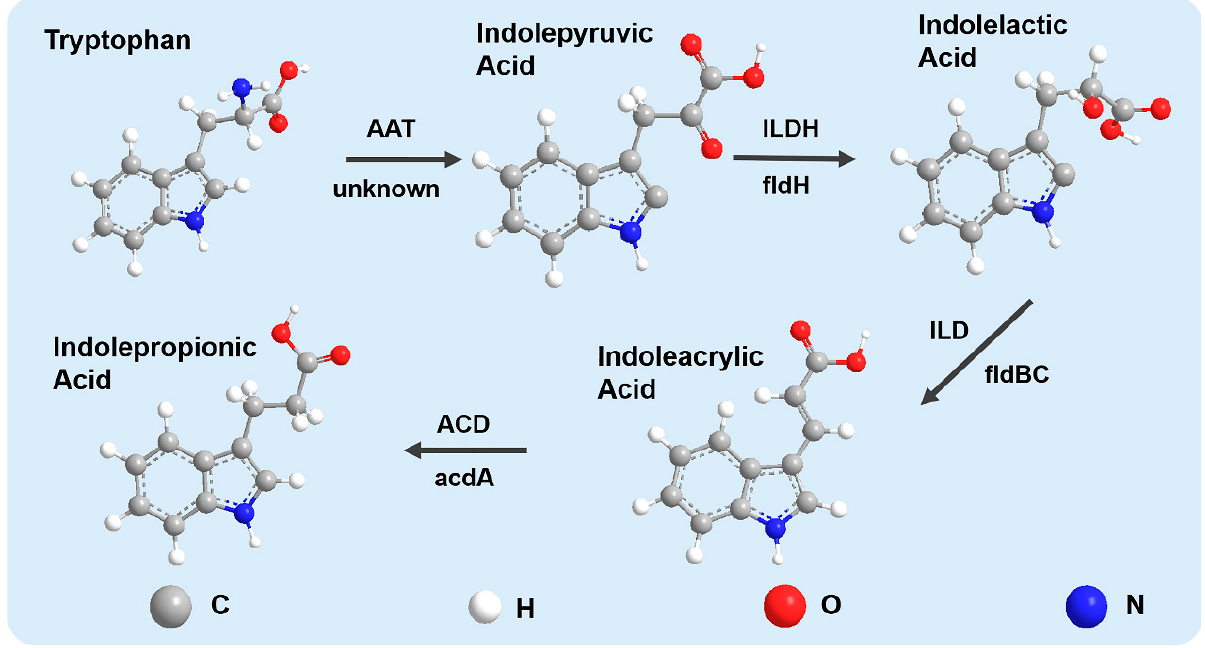
Figure 1. Metabolic process of dietary tryptophan converted to IPA by gut microbiota. The active enzymes required for this process are indicated above the arrow, and the genes encoding these enzymes in C. sporogenes are shown below. The enzymatic activity of AAT has been demonstrated in C. sporogenes cells, but so far, the gene encoding this enzyme has not been identified. AAT: Aromatic amino acid aminotransferase, ACD: Acyl-CoA dehydrogenase, ILD: Indolelactate dehydratase, ILDH: Indolelactate dehydrogenase. The ball-and-stick models of the molecules involved in the figure were drawn using ChemDraw (https://www.chemdraw.com.cn/ (accessed on 16 June 2022)) and chem3D (https://www.wavemetrics.com/project/Chem3D (accessed on 16 June